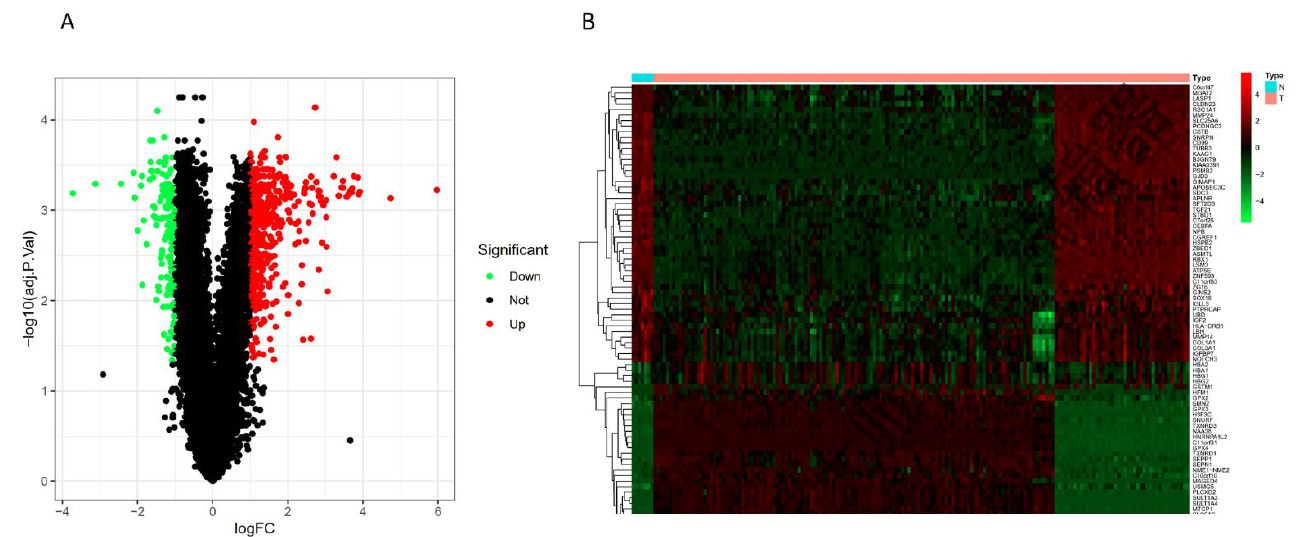
Figure 1. Visualization of differentially expressed genes (DEGs). ( A ) Volcano map of the DEGs in the training cohort. ( B ) Heatmap of the top 50 upregulated and downregulated genes.